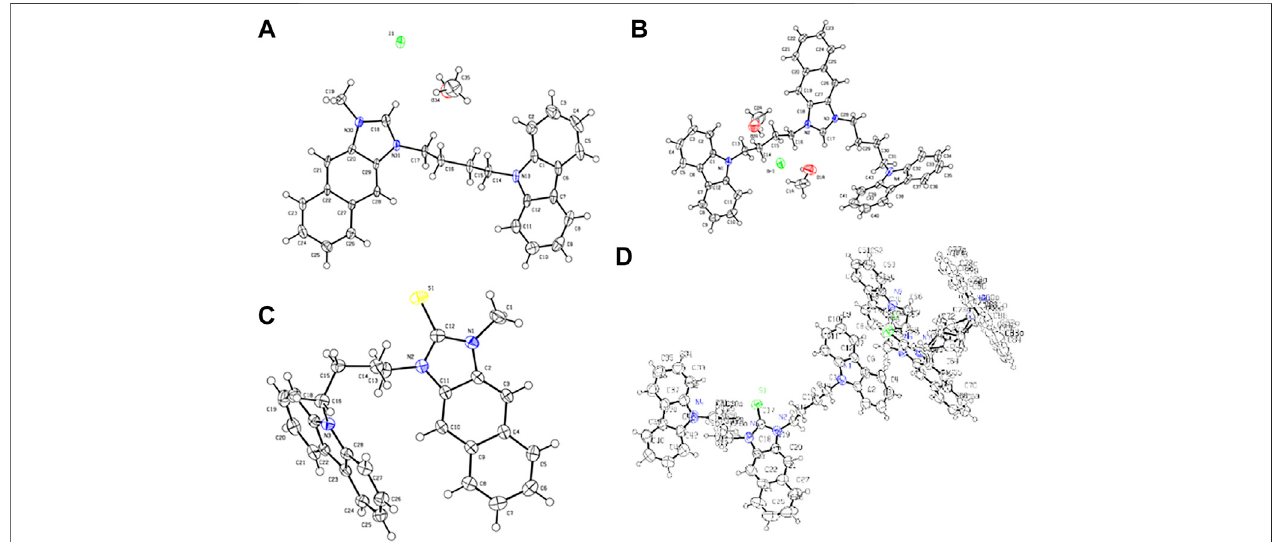
FIGURE 1 | Crystal structures of (A) CIM , (B) CIC , (C) CSM , and (D) CSC .